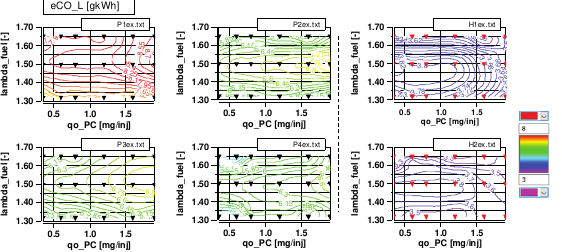
Fig. 18. The CO_L emission maps achieved for prechamber type P and type